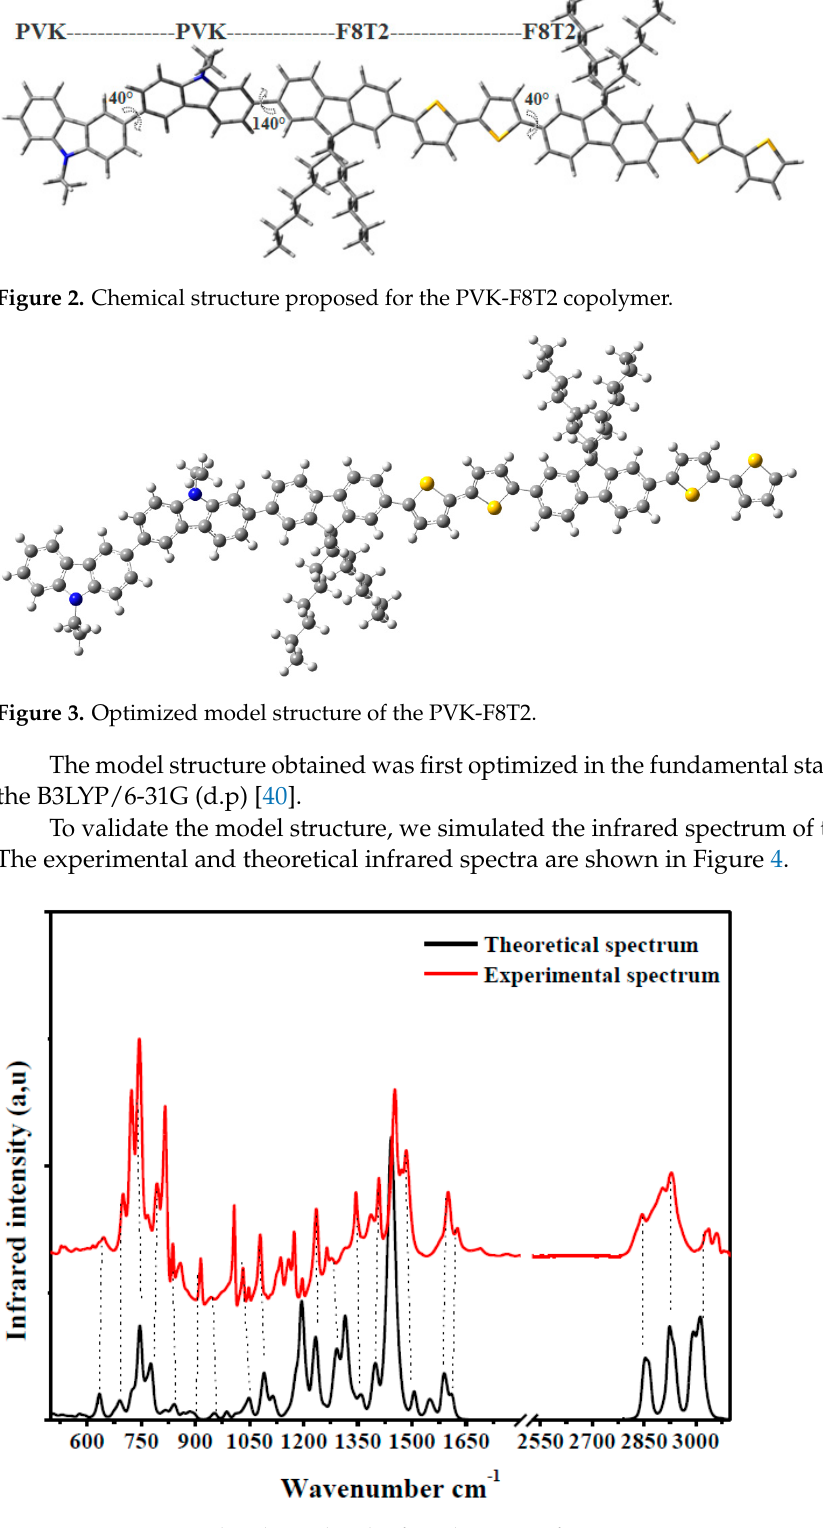
Figure 4. Experimental and simulated infrared spectra of PVK-F8T2.